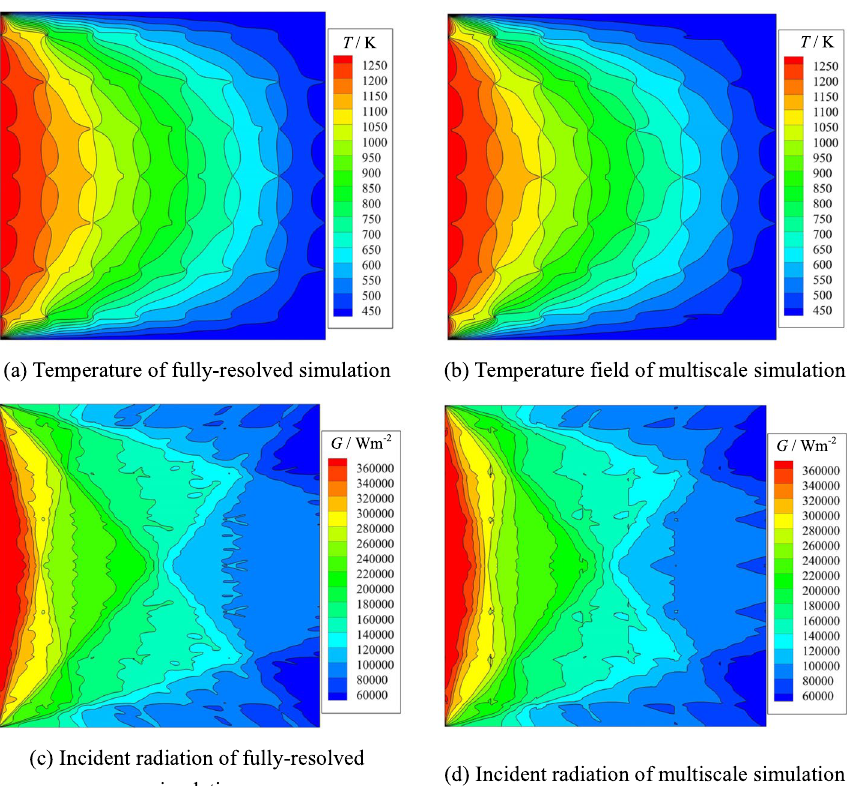
Fig. 10 Temperature and incident radiation fields for horizontally aligned